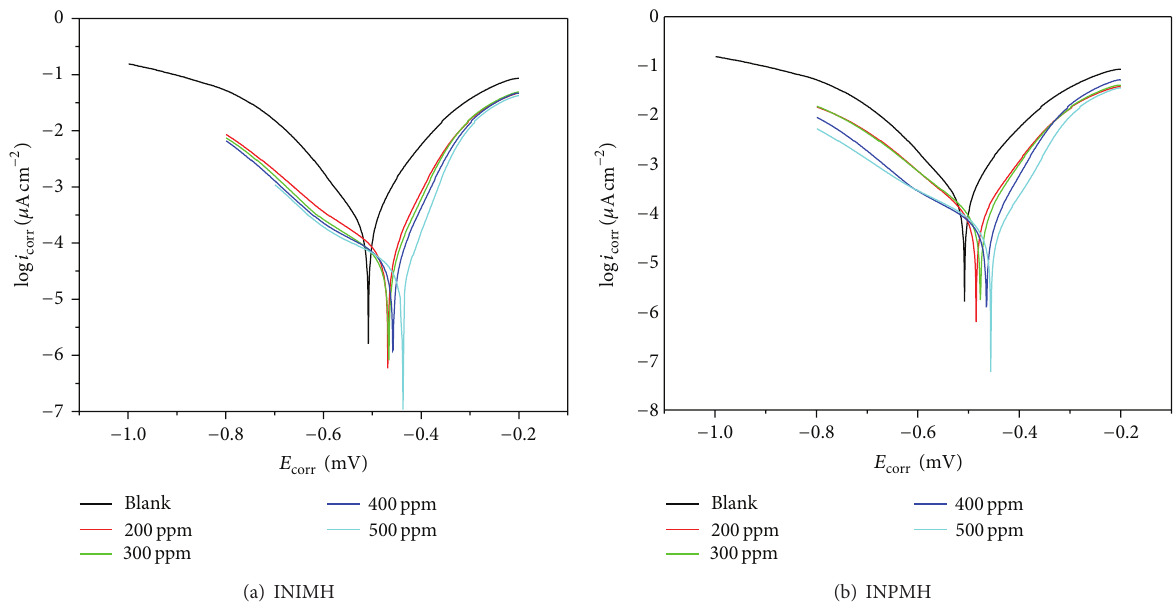
Figure 9: Polarization curves of MS in 0.5 MHCl in the presence of different concentrations of (a) INIMH and (b) INPMH.